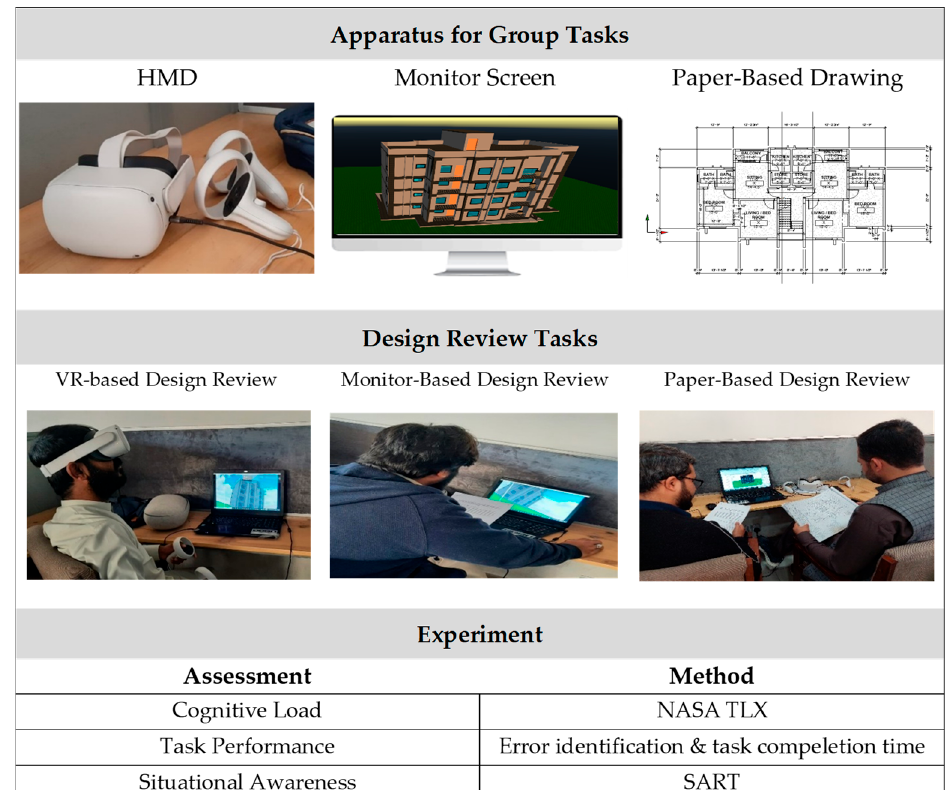
Figure 2. Experimental methodology.